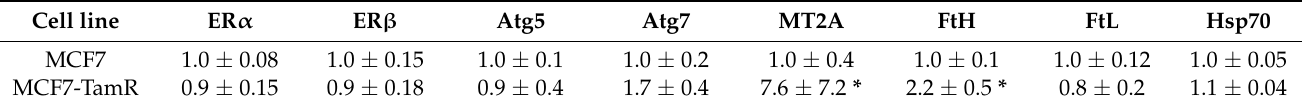
Table 1. Relative amount of estrogen receptor (ER), Atg protein, and lysosomal protective factor mRNAs in MCF7 and MCF7-TamR